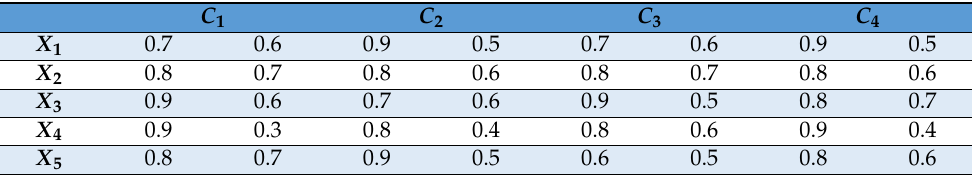
Table 2. Expert e 1 about energy resources under the given criteria. Table 2 . Expert 𝑒 (cid:2869) about energy resources under the given criteria.